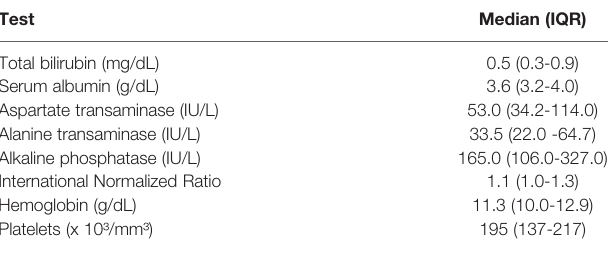
TABLE 3 | Laboratory analyses at the time of diagnosis of pseudocirrhosis (n = 86).